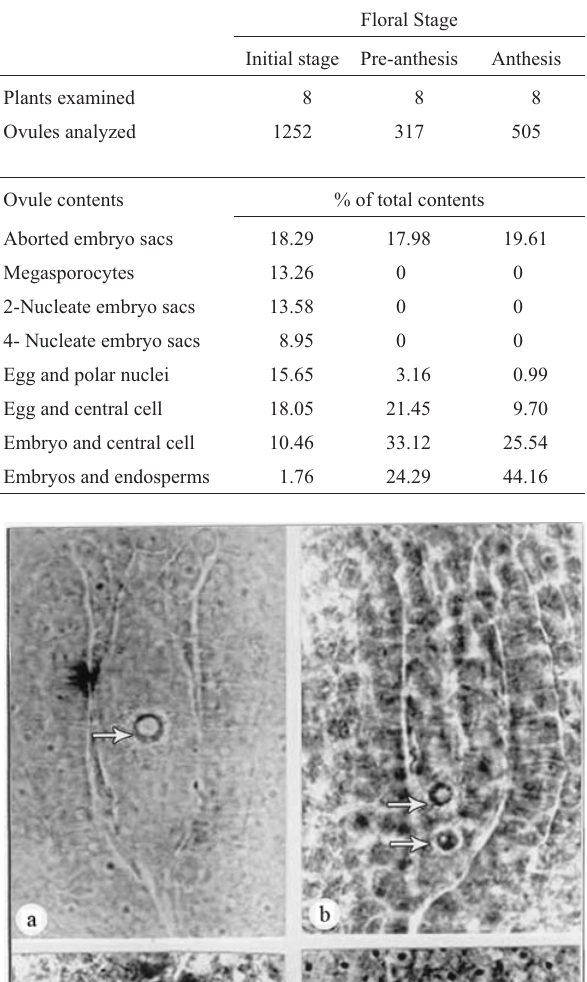
Table 2 - Contents of Eupatorium laevigatum ovules at different stages of floral development.